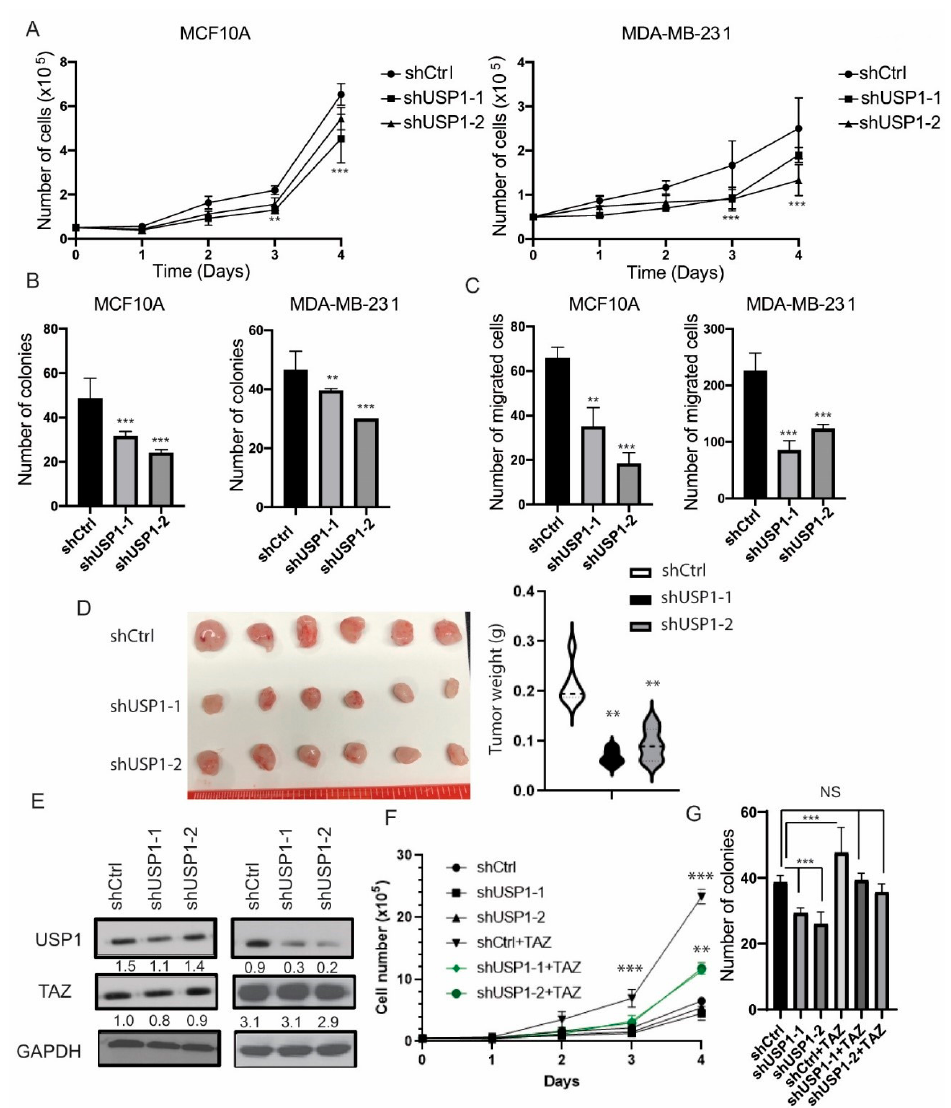
Figure 4. Loss of function of USP1 alters cell proliferation and migration. ( A ) Cell proliferation assay of MCF10A and MDA-MB-231 cells upon knockdown of USP1. ( B ) Quantification of clonogenicity assays after 11 days upon knockdown of USP1 in MCF10A and MDA-MB-231 cells. ( C ) Quantification of cell migration after knockdown of USP1 in MCF10A and MDA-MB-231 cells. ( D ) Images and quantification of tumor size of shCtrl, shUSP1-1 or shUSP1-2 MDA-MB-231 cells injected into the mammary fat pad of SCID mice, n = 6. ( E ) Immunoblot analysis of TAZ expression in shUSP1 MCF10A cells. GAPDH was used as a loading control. ( F ) Cell proliferation of control or TAZ-4SA transduced shUSP1 MCF10A cells. ( G ) Quantification of clonogenicity assay after 11 days of control or TAZ-4SA transduced shUSP1 MCF10A cells. Data are shown as the mean ± SD. Unpaired two-tailed student t-test: * p < 0.05, ** p < 0.01, *** p < 0.001. Western blots were quantified and normalized to